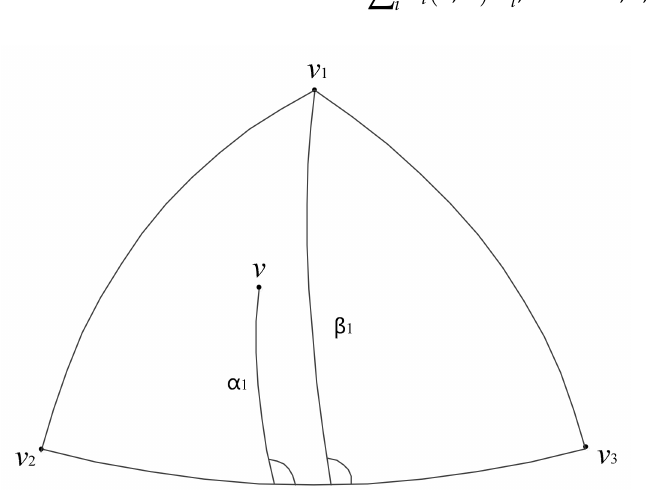
Figure 2. Computing spherical barycentric coordinates by Equation